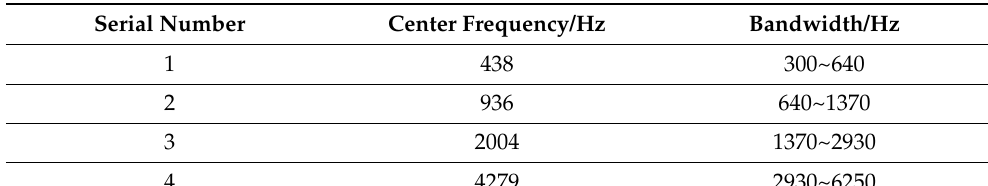
Table 2. Frequency distribution of bandstop filters.